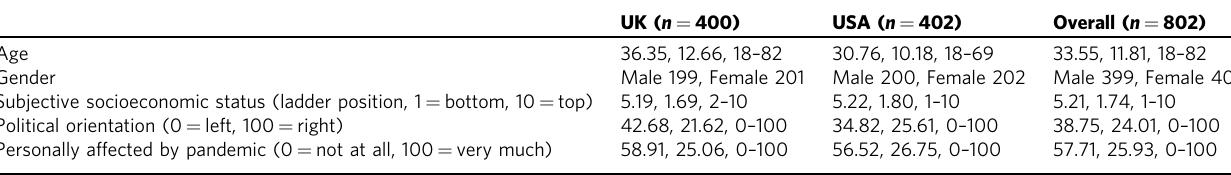
Table 1 Sociodemographic statistics for the respondent samples for study